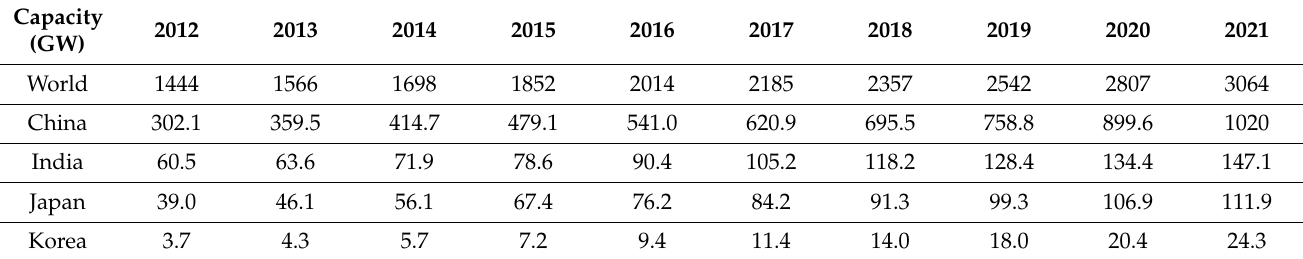
Table 1. World Total Renewable Energy Capacity (excerpted).